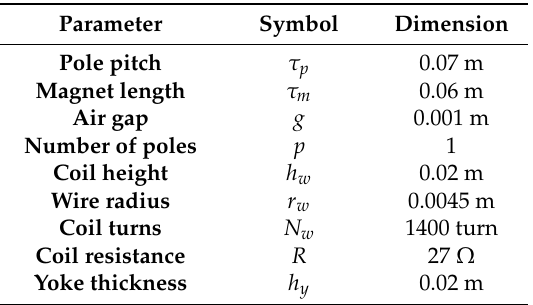
Figure 2. Damping coefficient and density variation. Table 2. Design parameters of the EM damper.